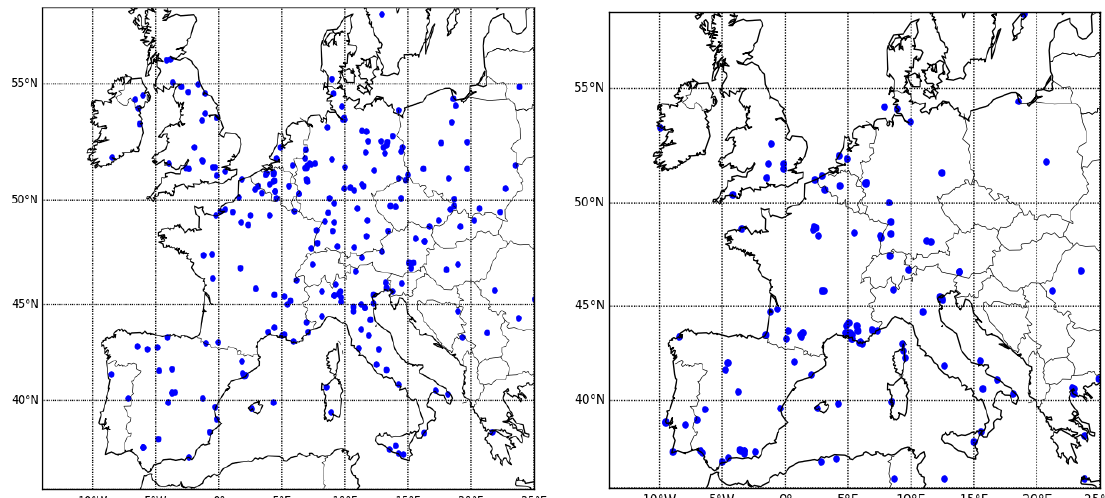
Figure 3. Maps of evaluation stations from AirBase network (184 stations) for PM 2.5 concentrations ( right panel ) and AERONET network (91 stations) for AOD ( left panel ).